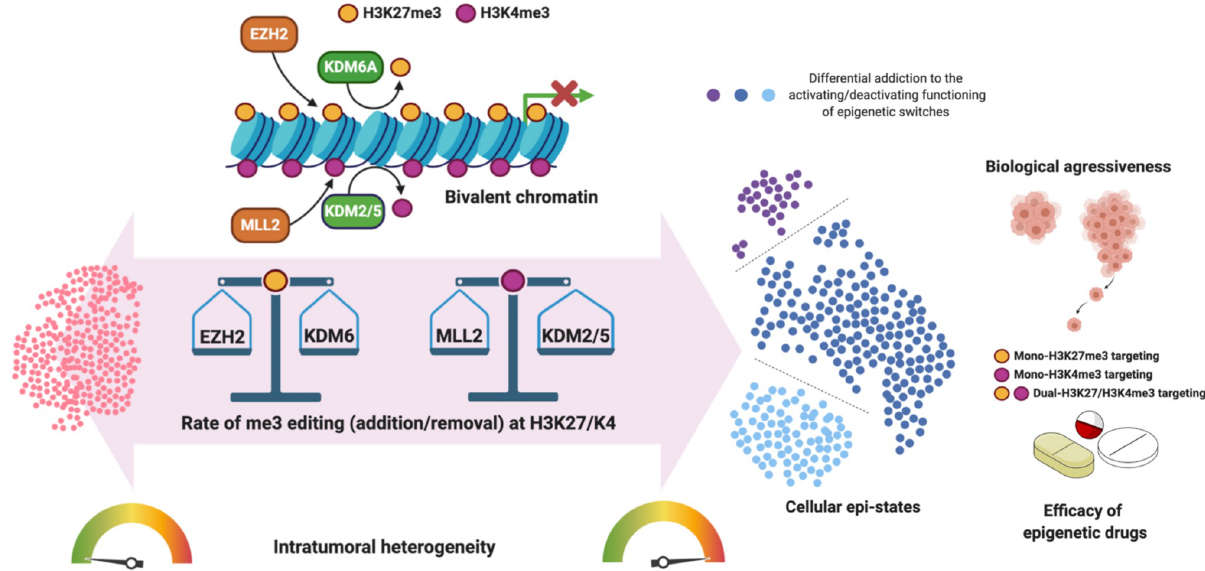
Fig 8. The heterogenous behaviour of epigenetic-regulatory systems as a determinant of the therapeutic efficacy of epigenetic drugs. The heterogenous functioning of the EZH2/KDM6A and MLL2/KDM5 switches may lead to cell-to-cell variability in terms of the addiction of cellular epi-states to certain rates of me3 editing (addition/removal) at H3K27/K4 bivalent chromatin. The proposed paradigm might accelerate future tool developments on epi-drugs applications with capability for patient stratification based on the dominant cell subtype in individual tumours. Our theoretical framework provides a coherent basis for the development of an in silico platform capable of identifying the epigenetic drugs combinations best-suited to therapeutically manage non-uniform responses of heterogenous cancer cell populations. Specifically, the more successful combinations involve modulators of the histone H3K4 and H3K27 demethylases KDM5 and KDM6A/UTX.